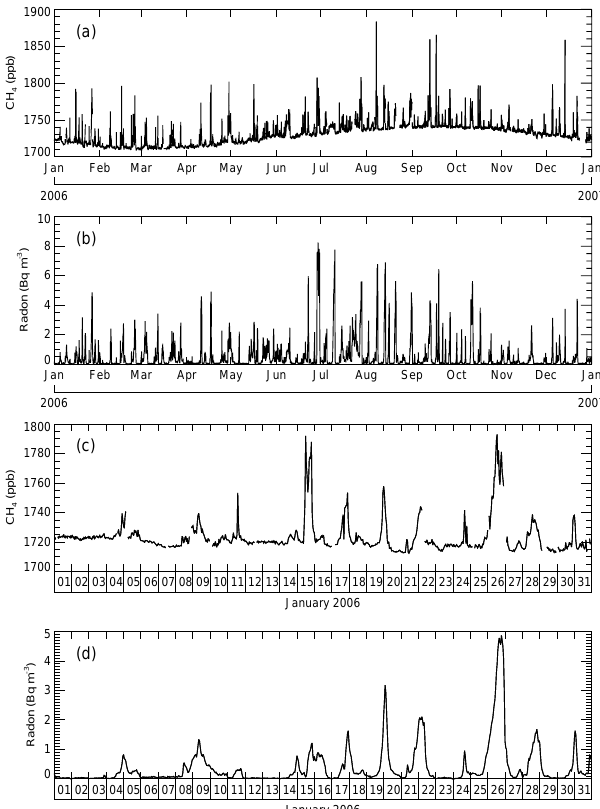
Figure 2. Cape Grim observations (a) 2006 methane data (b) 2006 radon data (c) January 2006 methane data and (d) January 2006 radon